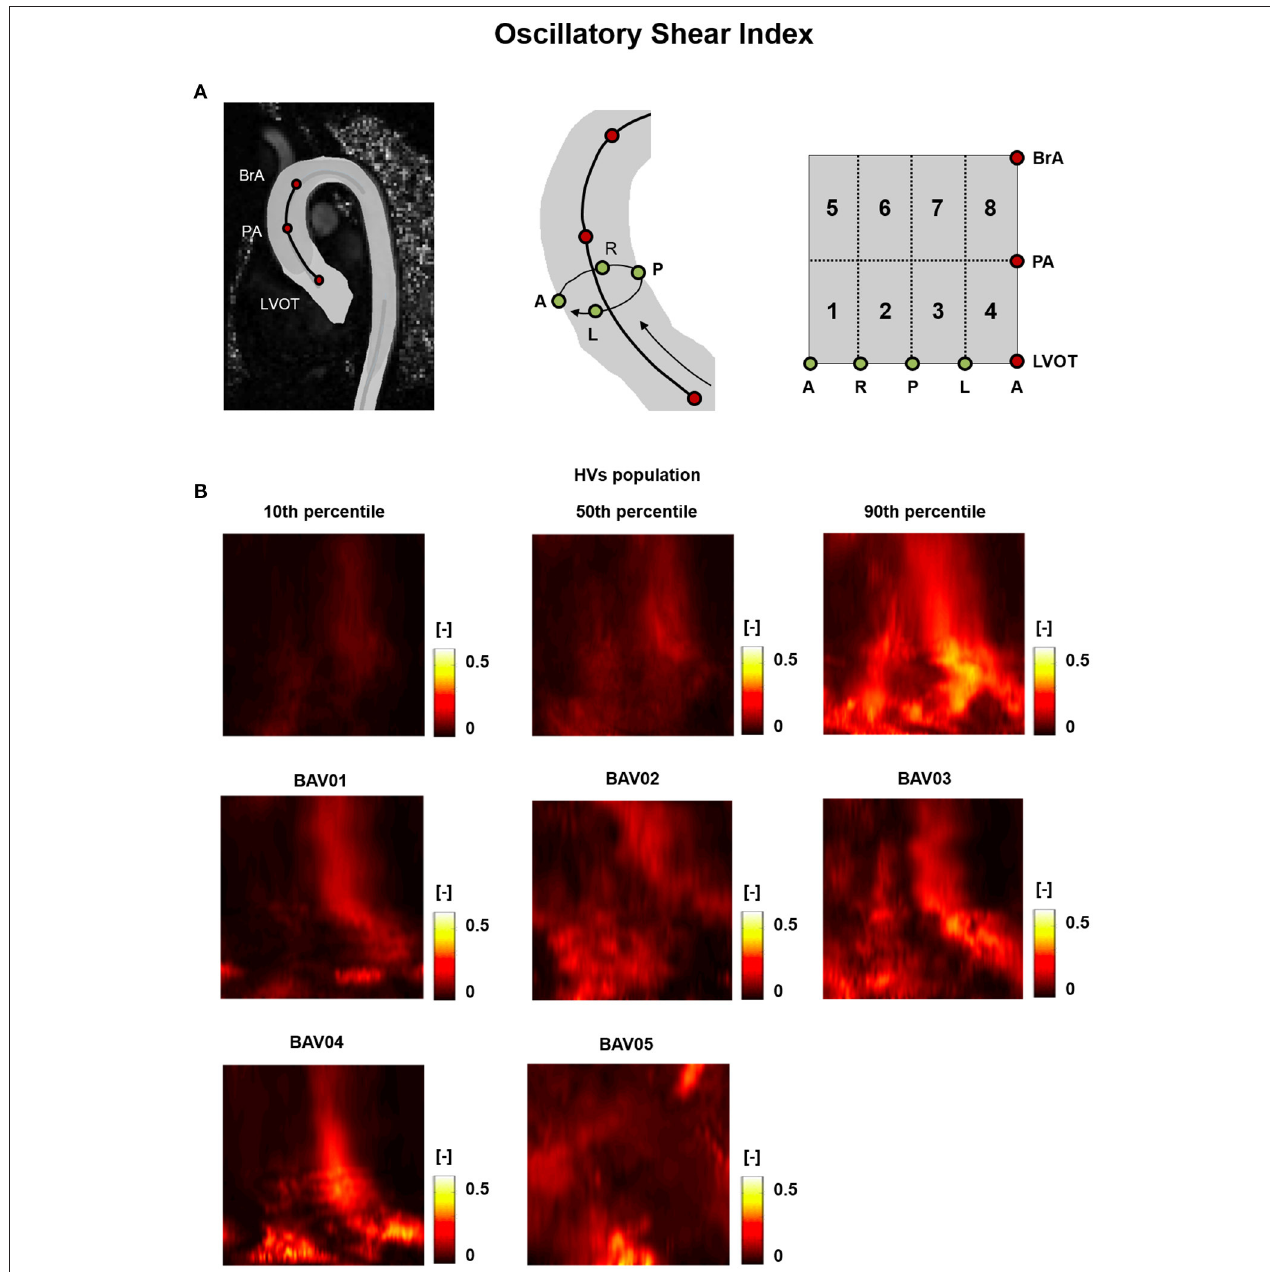
FIGURE 6 | (A) The 2D template detailed in Figure 3 is reported for the sake of clarity. (B) Oscillatory Shear Index (OSI) heat maps for HVs (represented as 10th, 50th, and 90th percentiles) and for each BAV patient obtained through time-averaging over the systolic phase.